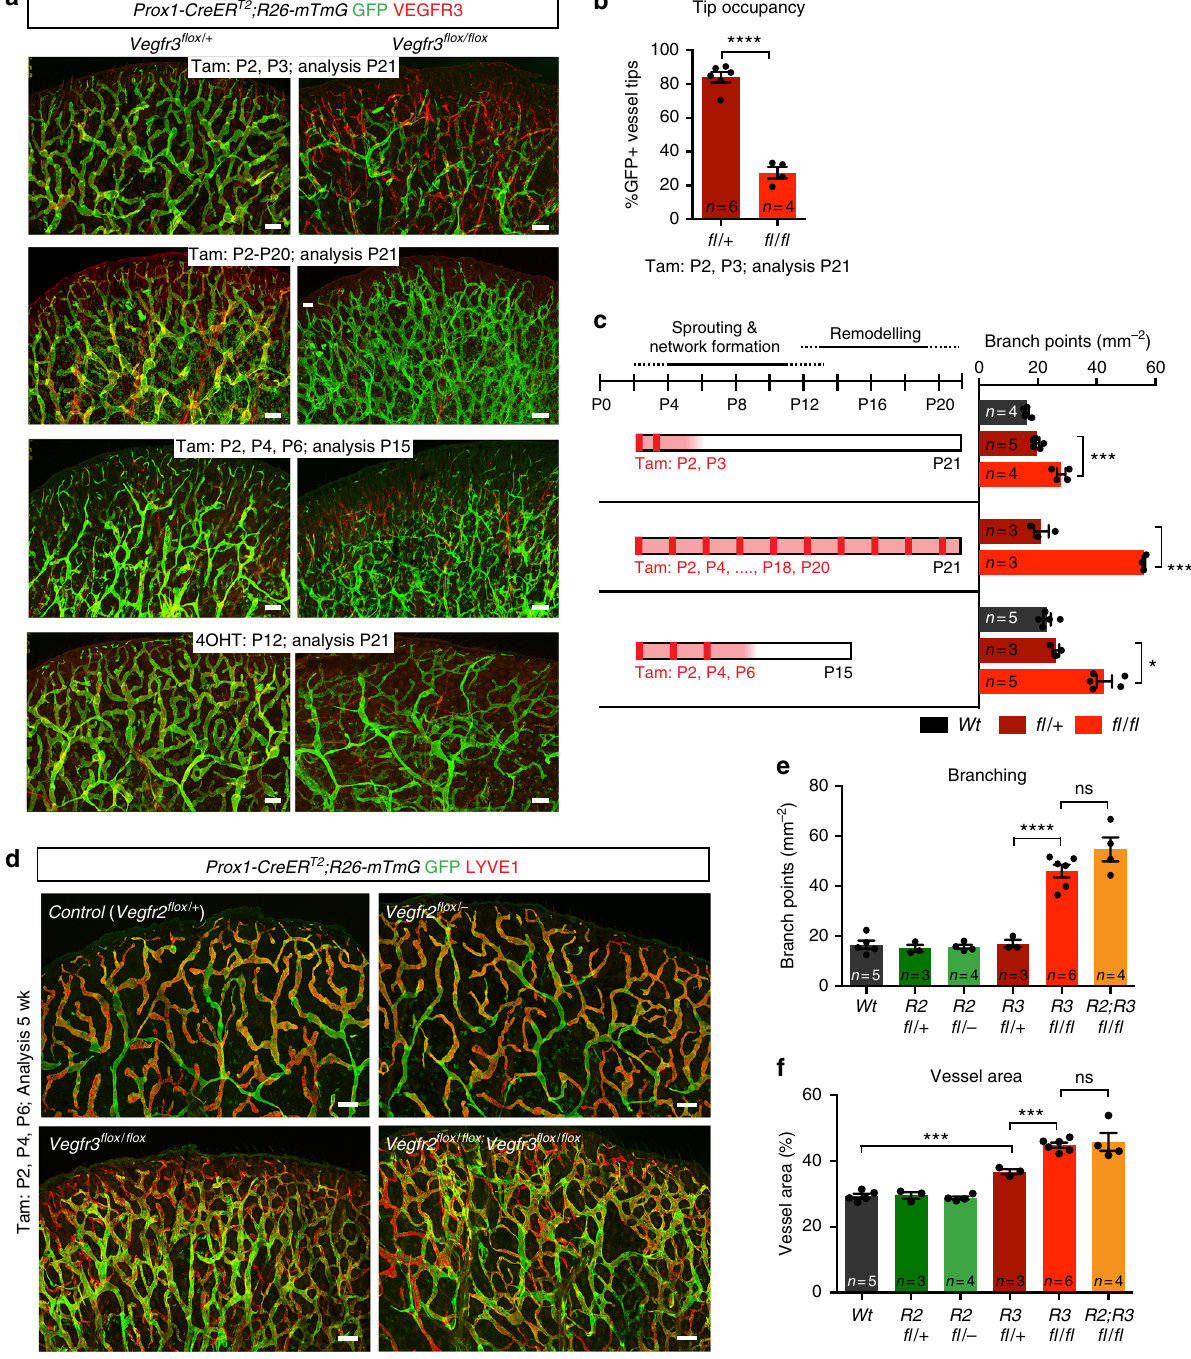
Fig. 2 Early post-natal deletion of Vegfr3 results in dermal lymphatic vessel hyperplasia during a critical post-natal period of 2 weeks. a Time course analysis of the effect of post-natal Vegfr3 deletion on dermal lymphatic development. Whole-mount immuno fl uorescence of ear skin of indicated stages and Tam/ 4-OHT treatment regimes. b Quanti fi cation of Cre-targeted (GFP + , Vegfr3 deleted) LECs in the distal vessel tips in P21 mice treated with Tamoxifen at P2 and P3. Bars represent mean ( n = 6 fl / + and n = 4 fl / fl mice) ± s.e.m. c Quanti fi cation of vessel branch points in ear skin analyzed in Fig. 2a after indicated Tam treatment regimes. Tamoxifen administration schedule (Cre induction, red ( n × 150 µ g); estimated effective period (72 h), light red) (left) is shown. Bars represent mean ( n = 3 – 5 mice, as indicated) ± s.e.m. d Whole-mount immuno fl uorescence of ear skin of 5 weeks old mice treated with Tamoxifen at P2, P4 and P6. e , f Quanti fi cation of vessel branch points and area in ear skin analyzed in Fig. 2d. Bars represent mean ( n = 3 – 6 mice, as indicated) ± s.e.m. * P < 0.05, *** P < 0.001, **** P < 0.0001. Two-tailed unpaired Student ’ s t test ( b , c , e , f ). Scale bars: 200 µ m ( a , d ). ns: not signi fi